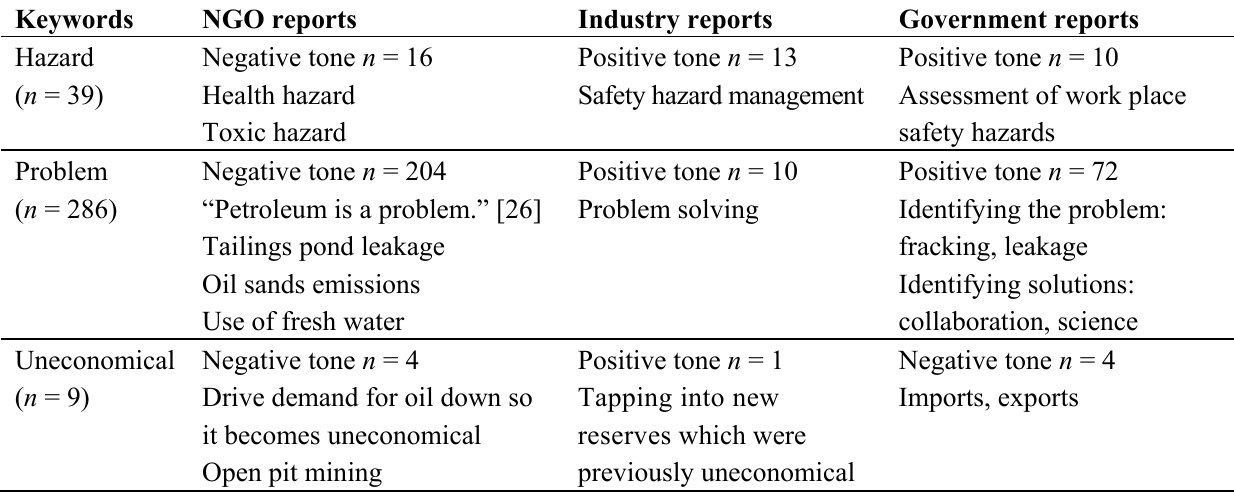
Table 6. Negative keywords with a positive spin in industry and government